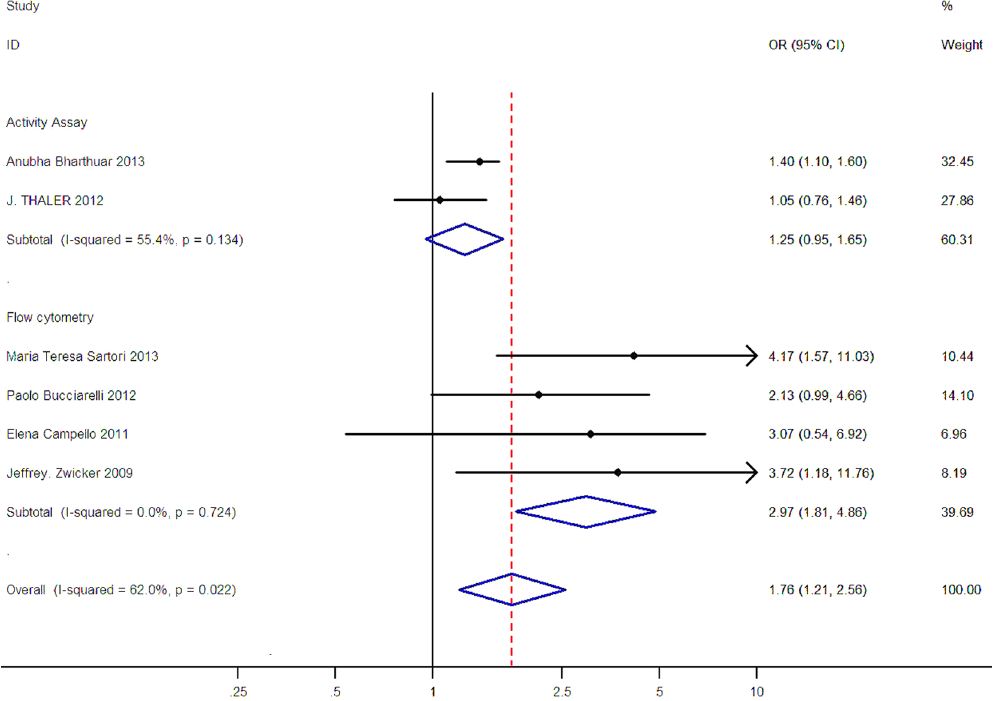
results of OR with its corresponding 95% CI.